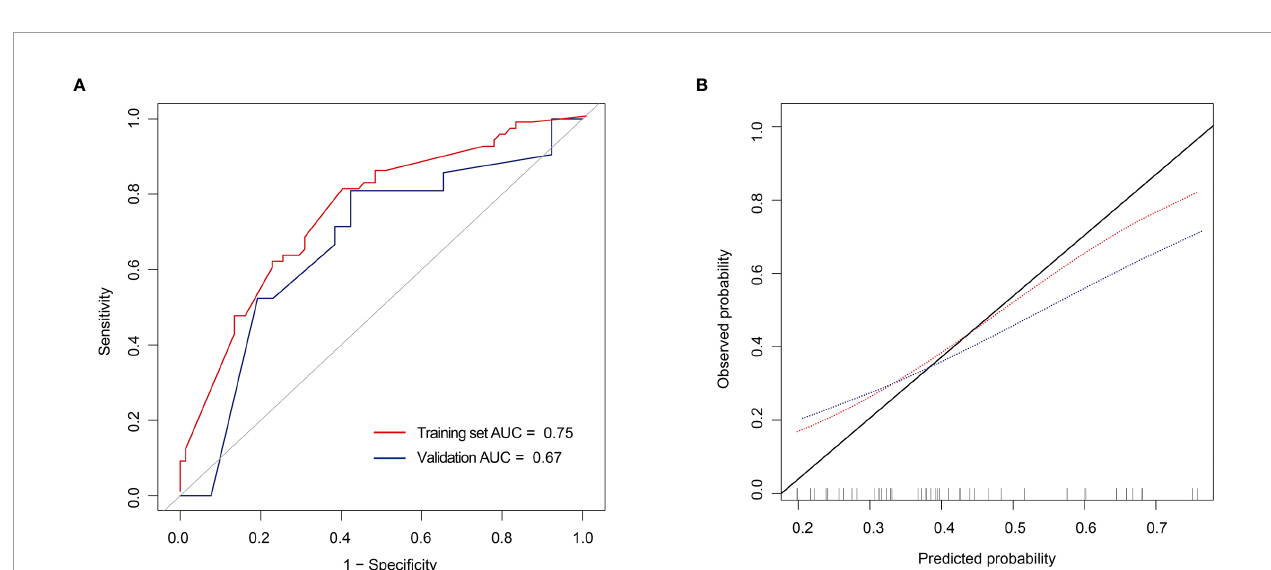
FIGURE 5 | Receiver operating characteristic (ROC) curves and calibration curves of the extreme gradient boosting (XGBoost) classi fi er (A) ROC curves of the XGBoost classi fi er in the training and validation set. (B) Calibration curves of the XGBoost classi fi er in the training and validation